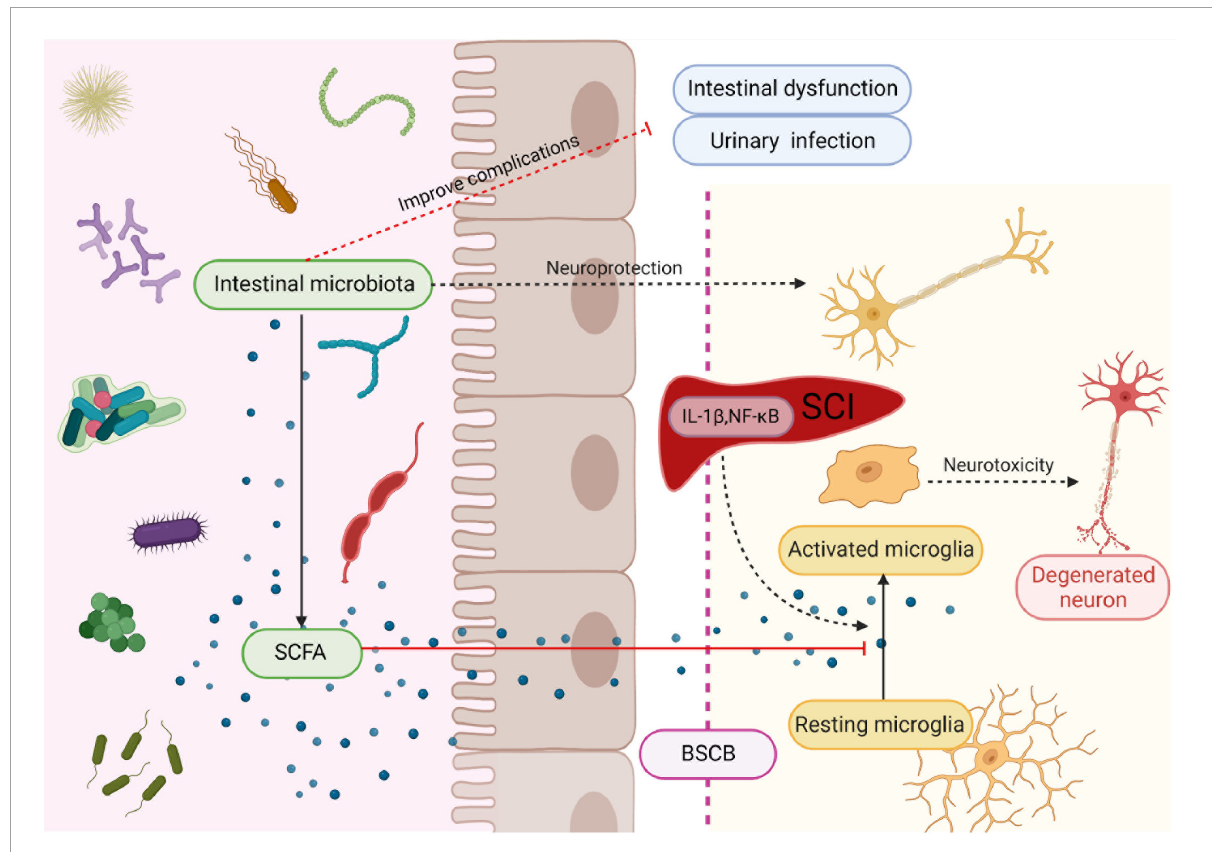
FIGURE2 Intestinal microbiota protects neuron and improves complications after SCI. Microbiota secretes SCFA to regulate maturation and activation of microglia, thereby suppressing their neurotoxicity. Created with